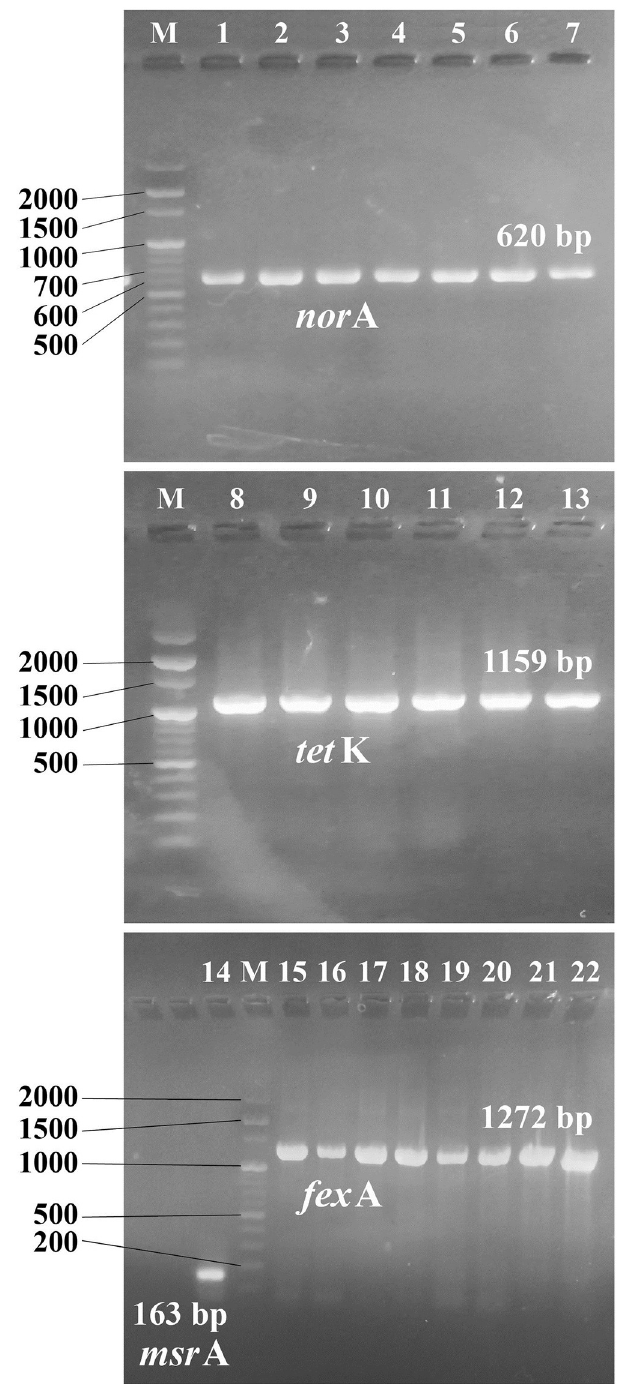
Fig 2. Electrophoretic analysis of PCR products of detected efflux genes. M; DNA ladder marker (3000 bp), Lanes from 1 to 7; nor A gene (620 bp), Lanes from 8 to13; tet K gene (1159 bp), Lane 14; msr A gene (163 bp) and Lanes from 15 to 22; fex A gene (1272